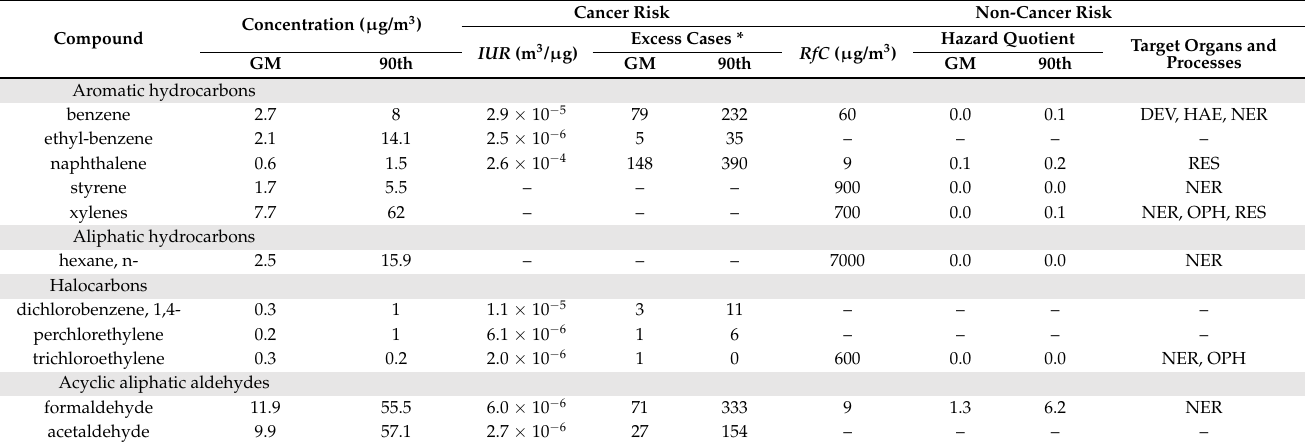
Table 4. Risk estimation for a selection of household air